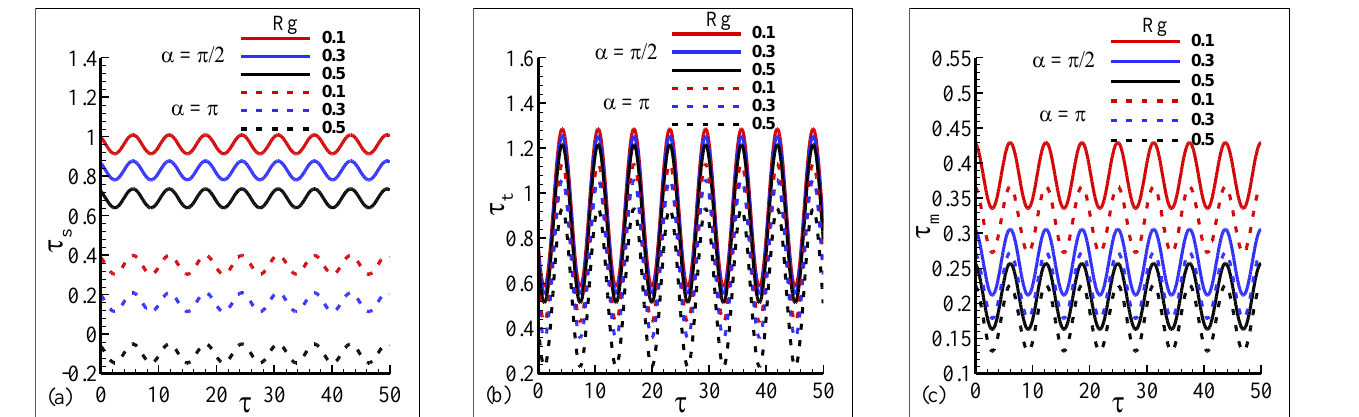
Figure 5. The geometrical plots of ( a ) 𝜏 𝑠 ( b ) 𝜏 𝑡 , and ( c ) 𝜏 𝑚 at 𝜋 2⁄ and 𝜋 positions with two values of reduced gravity Rg = 0.1,0.3 and 0.5 with some fixed 𝛾 = 0.1 , 𝜉 = 0.3 , Pr = 7.0 , and 𝜆 = 1.1 .